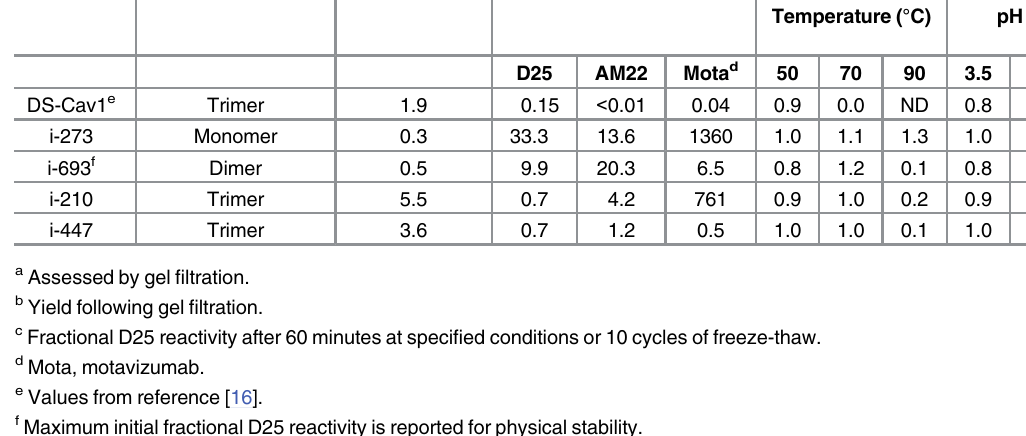
Table 1. Physical Characterization of Head-only RSV F Immunogens.